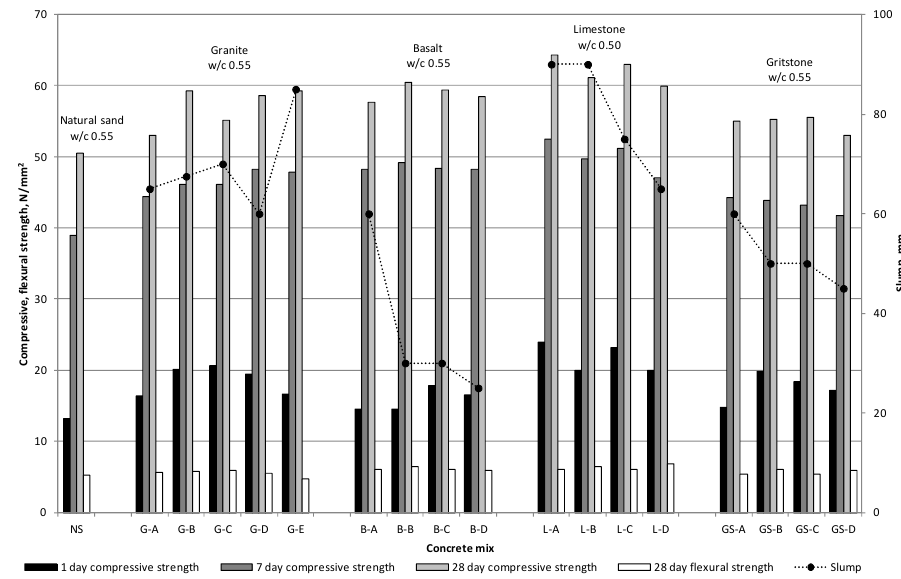
Figure 8. Water/Cement ratio controlled mix results and admixture dosages.